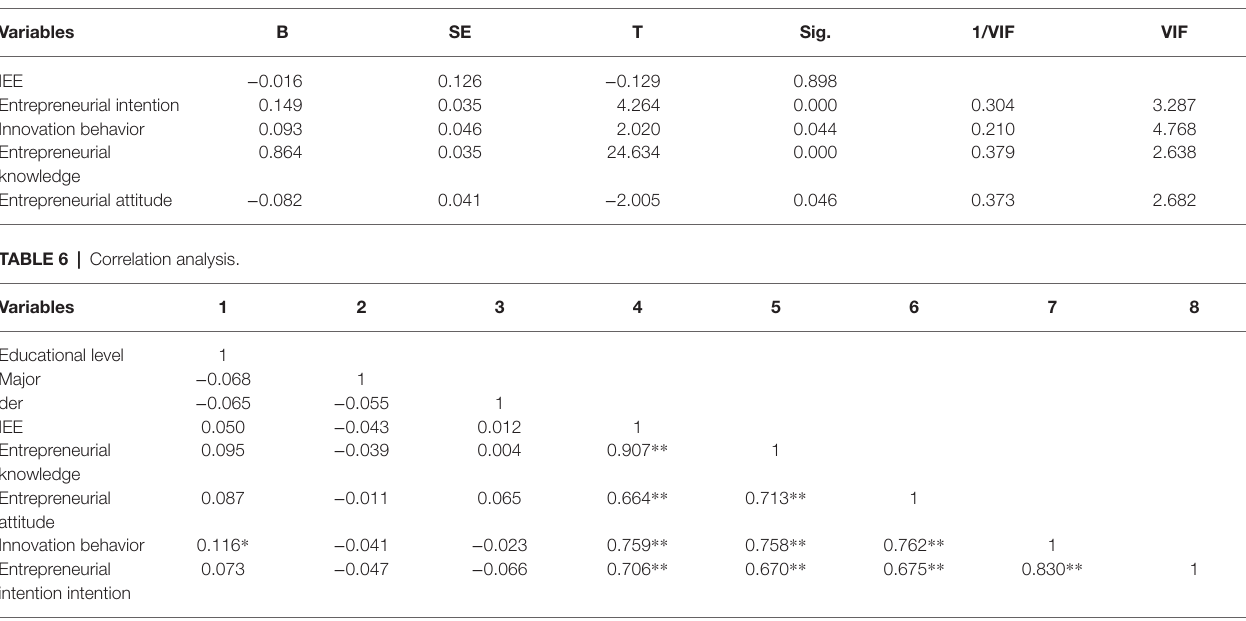
TABLE 5 | The data of common method deviation test (IEE is dependent variable).